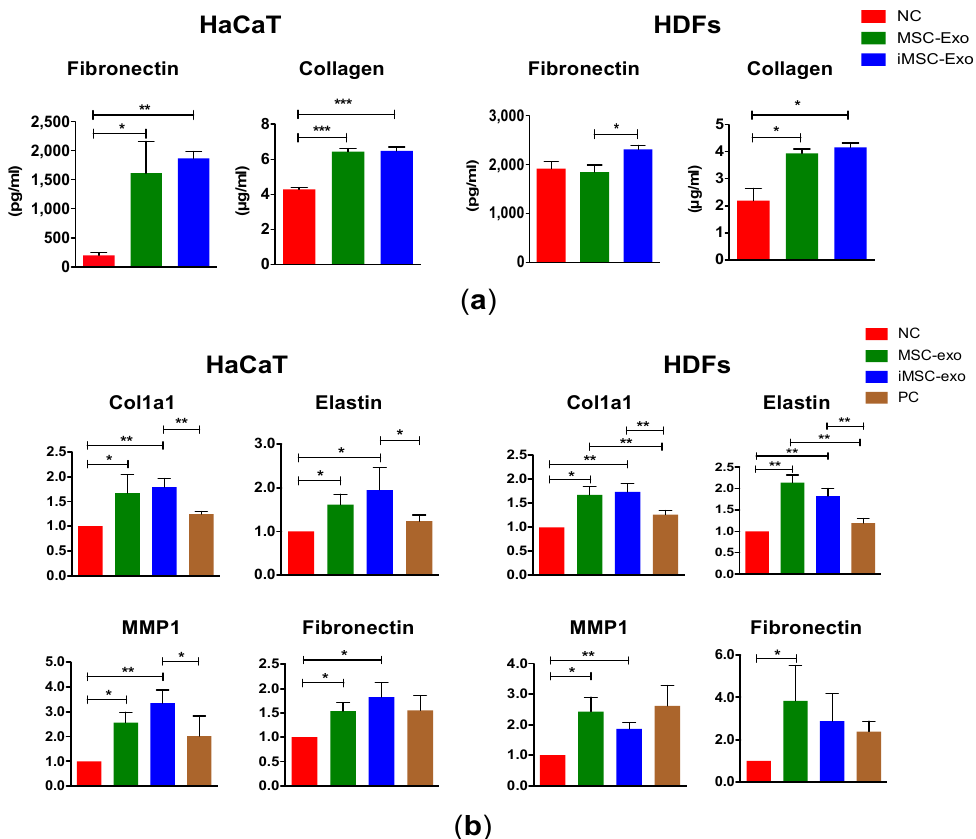
Figure 5. Comparison of the relative soluble protein and mRNA expression following exosome treatment. ( a ) A total of 20 µ g/mL of MSC-exo or iMSC-exo were incubated with HaCaT and HDFs for 48 h, and the concentration of fibronectin and collagen was measured using a Human Magnetic Luminex ® Screening Assay and SirCol assay kits, respectively. ( b ) Exosome-treated HaCaT and HDFs were subjected to qRT-PCR analysis and the expression of each gene was normalized against the expression detected in the non-treated negative control (NC). Cells cultured with serum (10%) were used as positive control (PC). Negative control (NC) was cells cultured without serum. All data are expressed as mean ± standard deviation (SD) from three replicates. * p < 0.05, ** p < 0.01, *** p < 0.005.